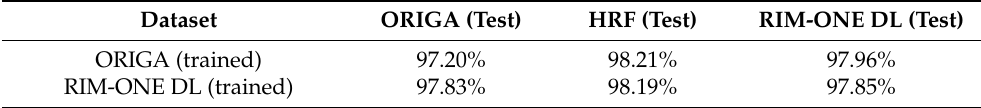
Figure 10. Cross-Validation Results where the model is trained on the RIM ONE DL dataset and test on the ORIGA dataset. Table 5. Performance comparison of cross-dataset